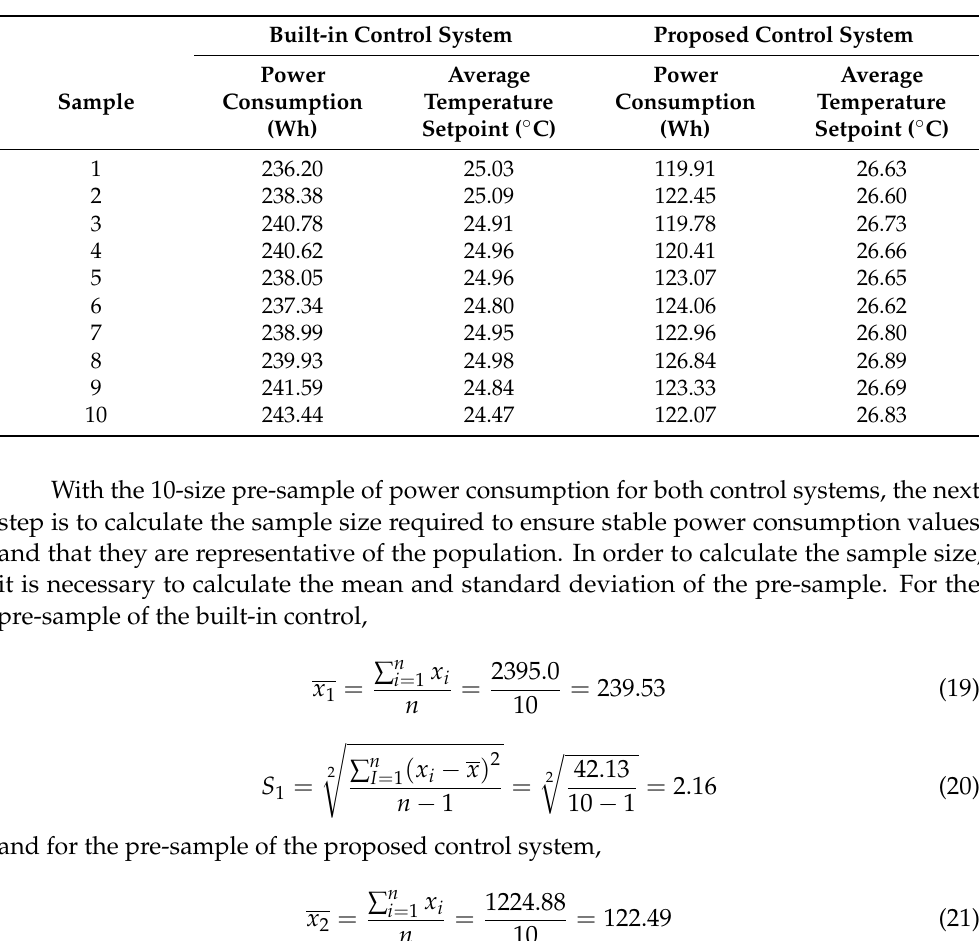
Table 4. Sample of power consumption of the HVAC equipment with the built-in and the proposed control